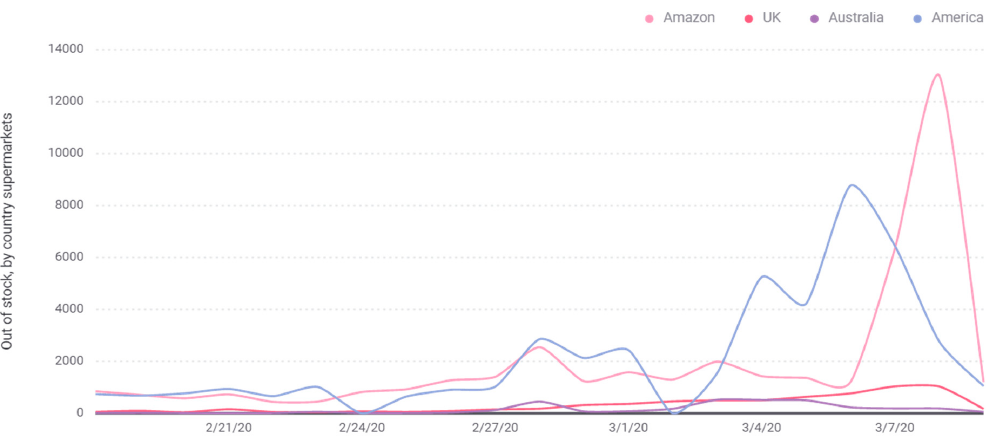
Figure 4. Mentions of “Out of Stock” Alongside a Store Name (Source: Brandwatch Consumer Research, 2020).